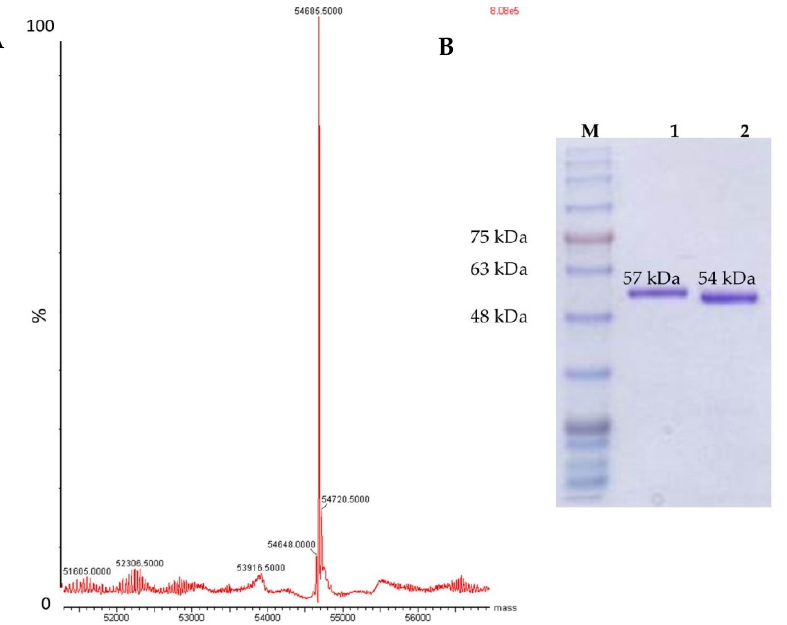
Figure 3. ( A ) Mass spectrometry of rhPEPD after His-Tag removal. ( B ) SDS-PAGE analysis, M— molecular mass markers, lane 1—rhPEPD with His-Tag, and lane 2—rhPEPD without His-Tag (after its removal with Xa protease).